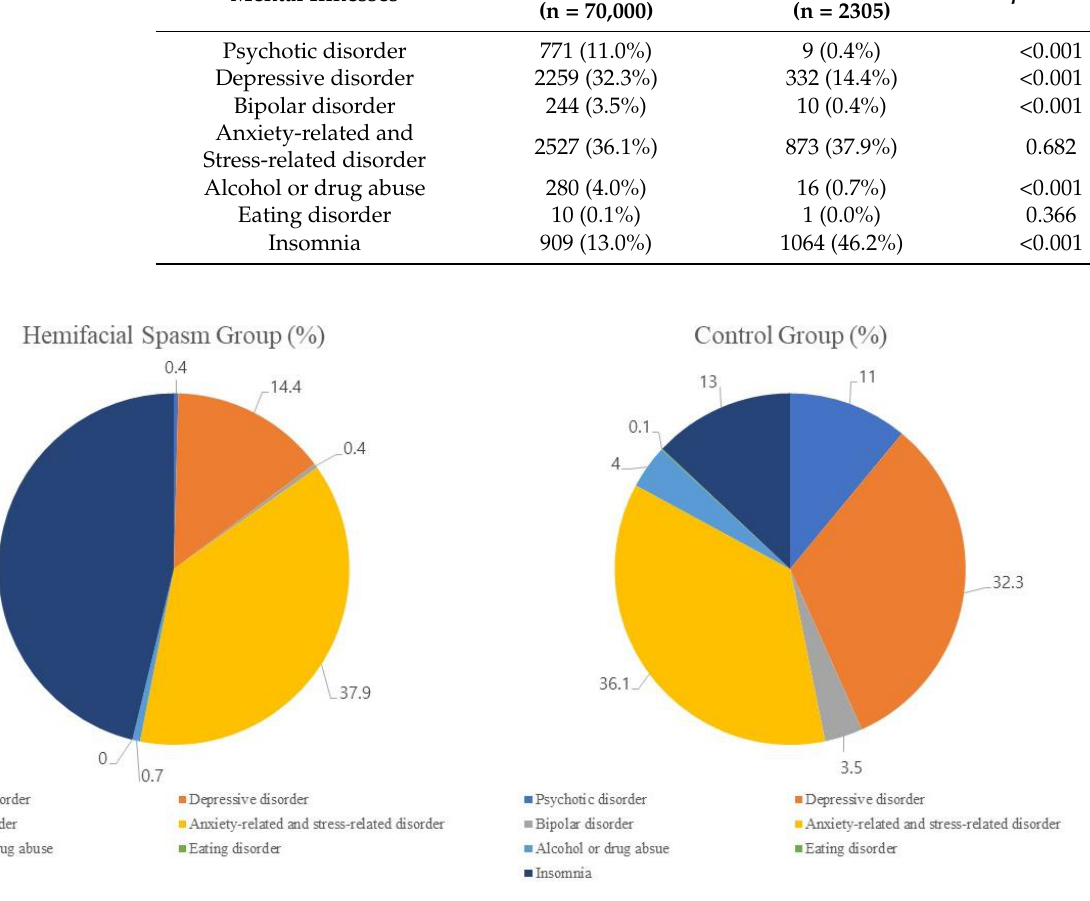
Figure 2. The distribution of mental illnesses in the hemifacial spasm group and the control group .